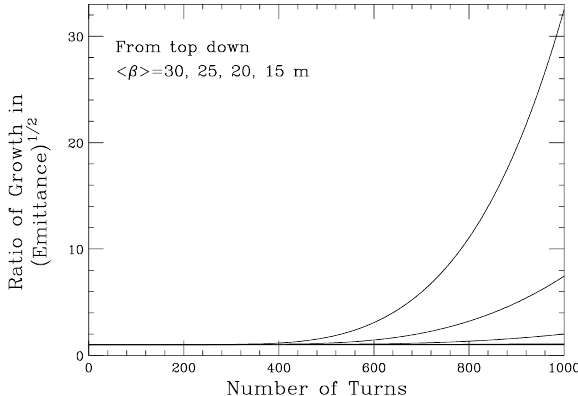
FIG. 15. Beam-breakup growth of the 13-cm bunch interact- ing with a broadband impedance of Q (cid:1) 1 , Z (cid:1) (cid:1) 0.1 M V (cid:1) m at the angular resonant frequency of v r (cid:1) 50 GHz. The total growths at 1000 turns reach 32.50, 7.4, 2.0, 1.09, and 1.006, respectively, for (cid:8) b (cid:9) (cid:1) 30 , 25, 20, 15, and 10 m.